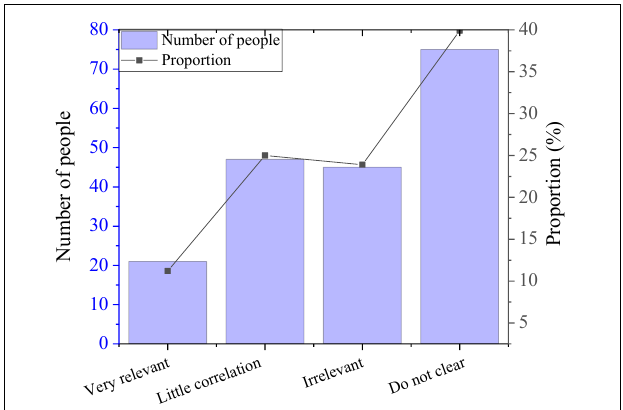
FIGURE 5 | PE majors’ cognition on the relationship between their major and entrepreneurship.